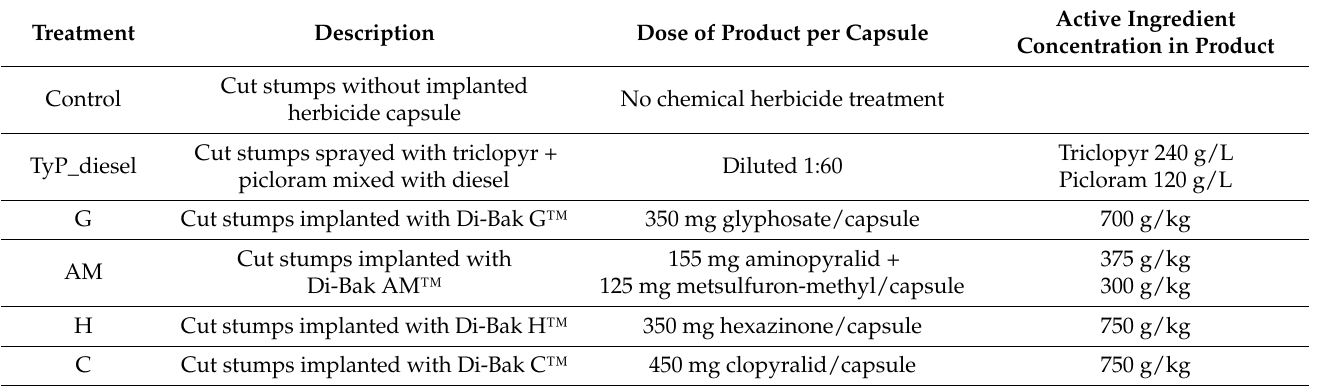
Table 2. Chemical herbicide treatments for cut stump